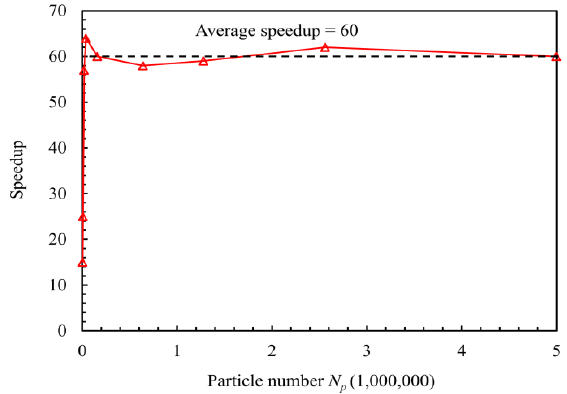
Figure 15. Speedups with different model sizes for dam break runouts. Table 4. Speedups of CPU and GPU parallel simulations in dam break cases (10,000 incremental steps).